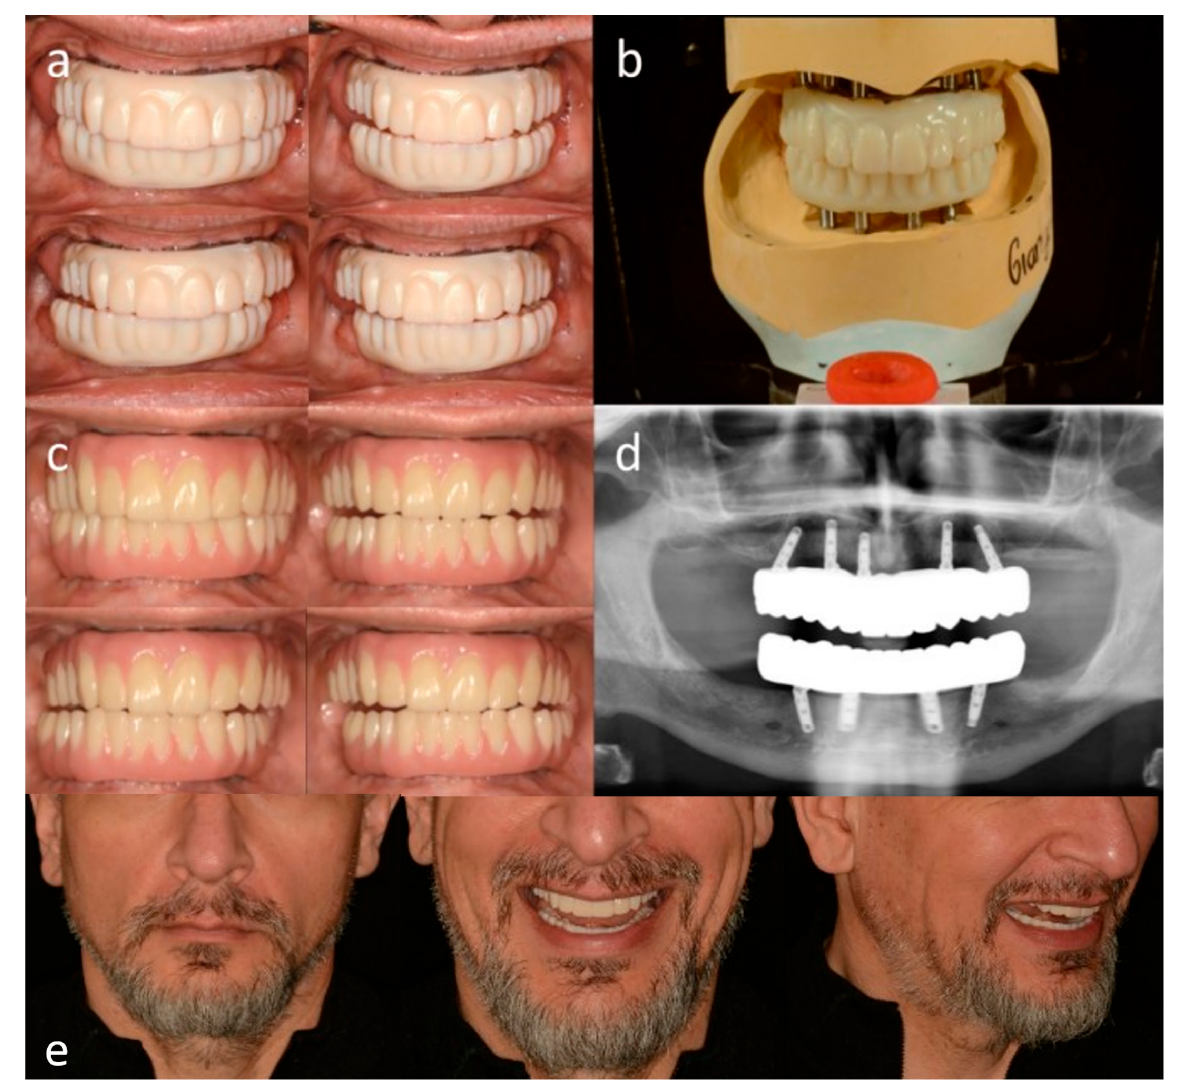
Figure 12. 3D-printed prototypes and definitive prostheses. ( a ) Intraoral try-in of bars and 3D-printed overlays. ( b ) Articulated 3D-printed overlays and titanium bars with a custom incisal guide table ( c ) Intraoral photograph of definitive prostheses ( d ) The final panoramic radiograph. ( e ) The esthetics, phonetics, and restitution of facial support.